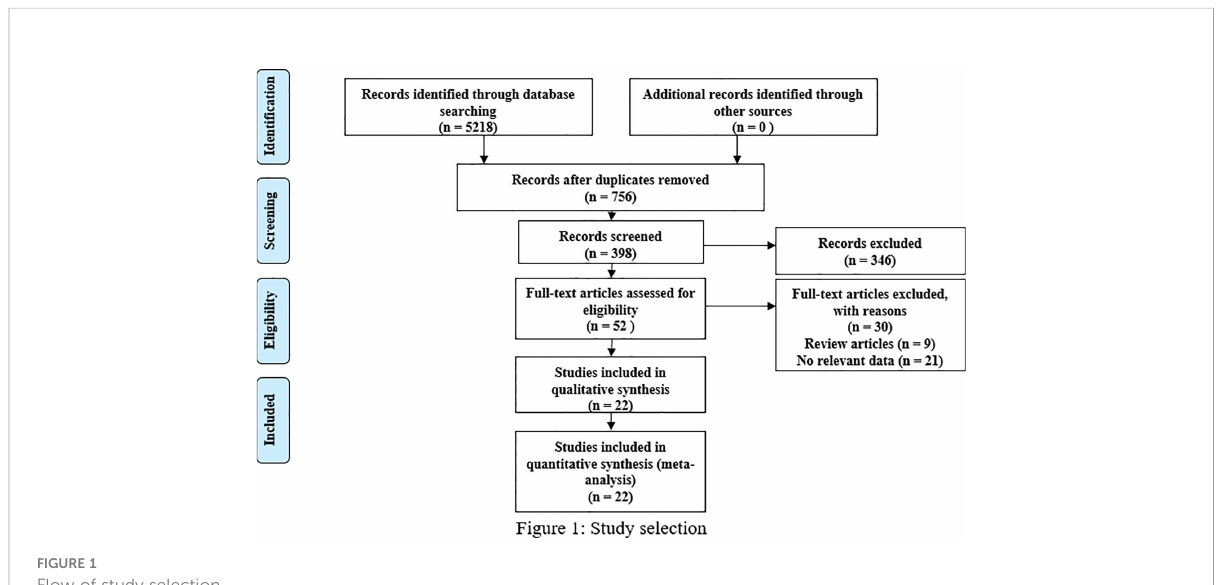
FIGURE 1 Flow of study